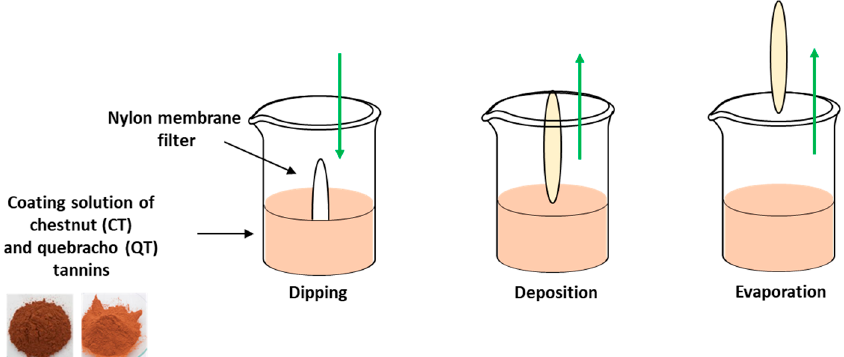
Figure 2. Schematic representation of the dip coating technique for thin film deposition.